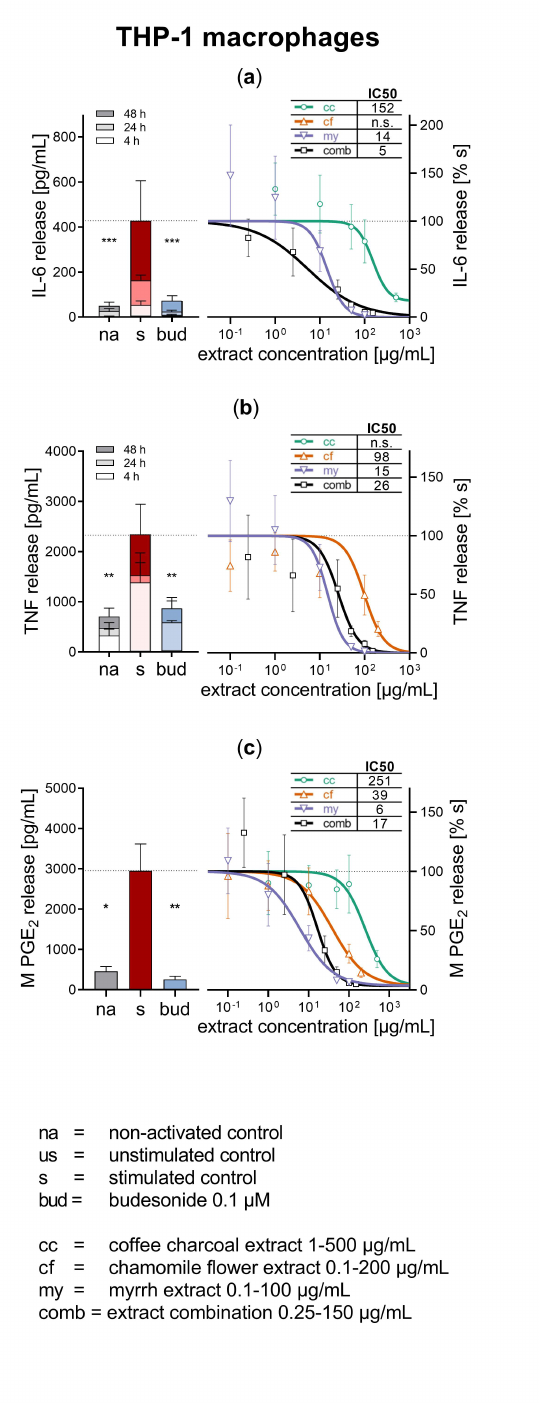
Figure 2. Pharmacological e ff ects of myrrh, co ff ee charcoal and chamomile flower extract and the three-fold combination on inflammatory mediator release from the THP-1 macrophages ( a – c ) and the intestinal epithelial cell (IEC) monolayers ( d – f ) and transepithelial electrical resistance (TEER) di ff erence ( g ) after 48 h of inflammatory stimulation and treatment in comparison to the controls. Mean ± standard error of the mean. * p < 0.05, ** p < 0.01, *** p < 0.001, **** p <